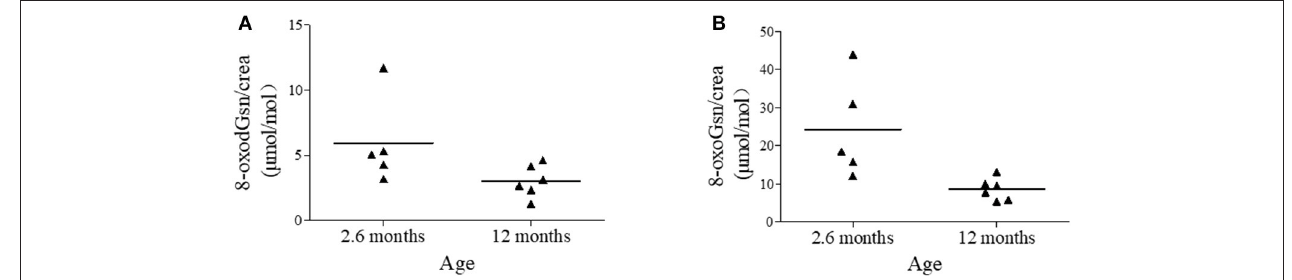
FIGURE 3 | Urinary 8-oxodGsn and 8-oxoGsn levels in babies. (A) Urinary 8-oxodGsn in babies of average 2.6-months and 12 months. (B) Urinary 8-oxoGsn in babies of average 2.6-months and 12 months.